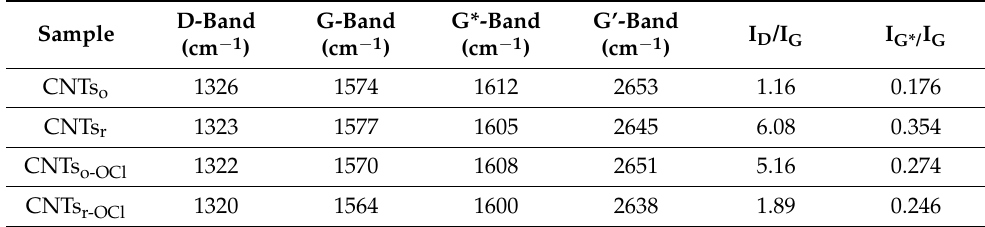
Table 2. Wavenumbers of the D, G, G*, and G’ Raman bands, and scattering intensities ratios (I D /I